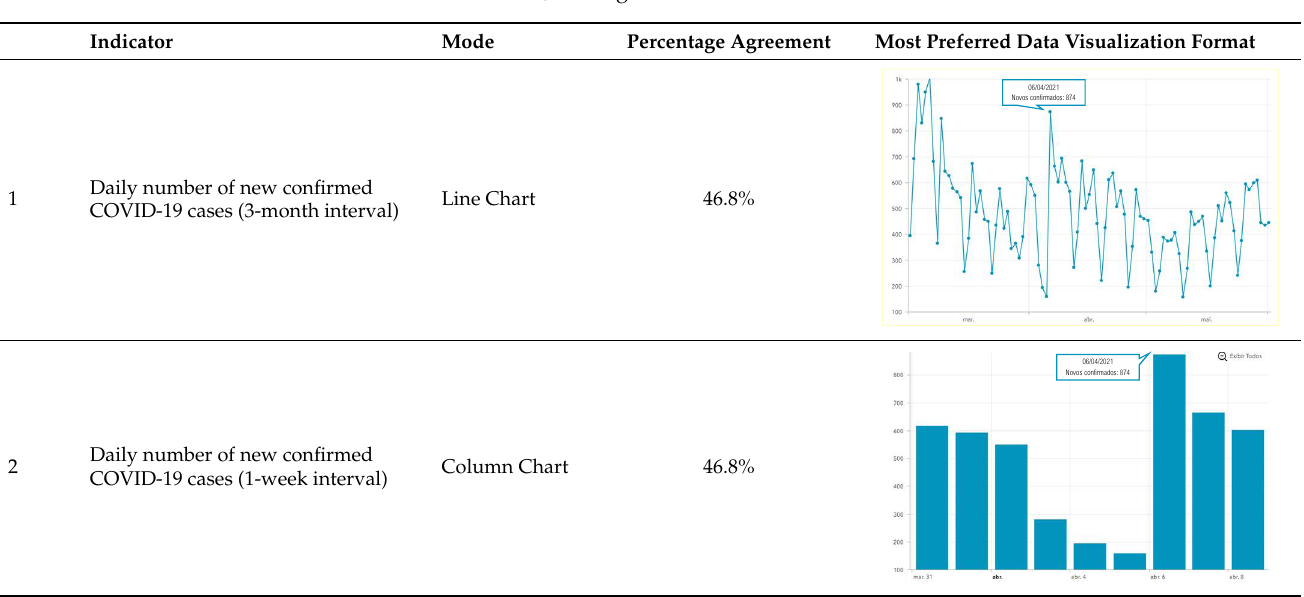
Table 4. Main Web-Delphi results for the second round (majority percentages in bold). Note: Some figure contents are written in Portuguese. On Indicators 1-6, data labels (callouts) inform the value of the indicator pointing to a specific day; On Indicators 8 and 10, “Homens” refers to Males and “Mulheres” to Females; The legend title in Indicator 11 refers to “Number of new confirmed cases”.